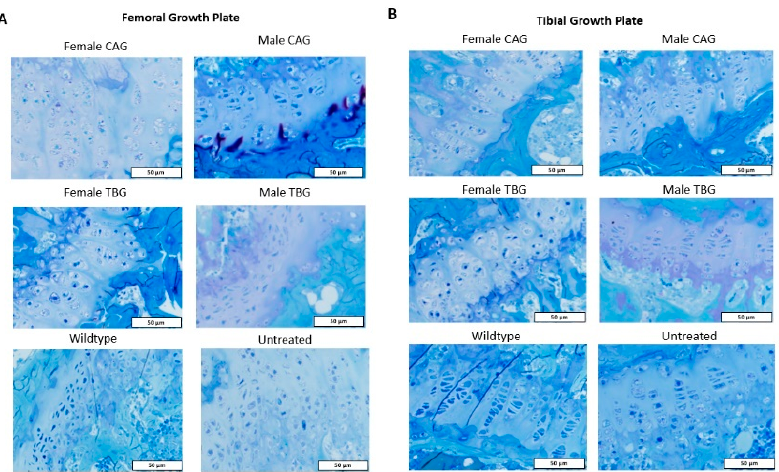
Figure 8. Toluidine blue staining of AAV8 CAG-hGALNS (Group Two) and TBG-hGALNS (Group Three) treated male and female ( A ) femoral growth plates, ( B ) tibial growth plates.